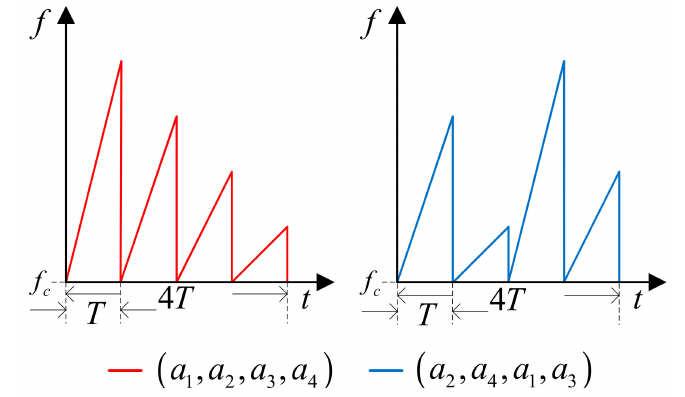
Figure 5. Example of the waveform of the generated waveform